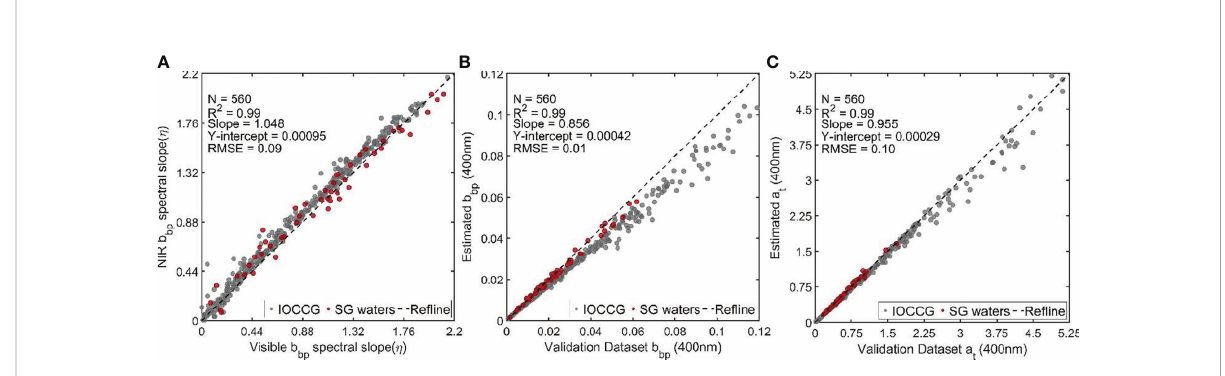
FIGURE 2 Comparison of (A) spectral slope of particulate backscattering h computed using visible bands (400-700 nm) and NIR bands (779-865). (B) blended QAA derived and IOCCG+SG quanti fi ed b bp (400nm). (C) blended QAA derived IOCCG+SG quanti fi ed a t (400nm) for Sentinel OLCI spectral bands.